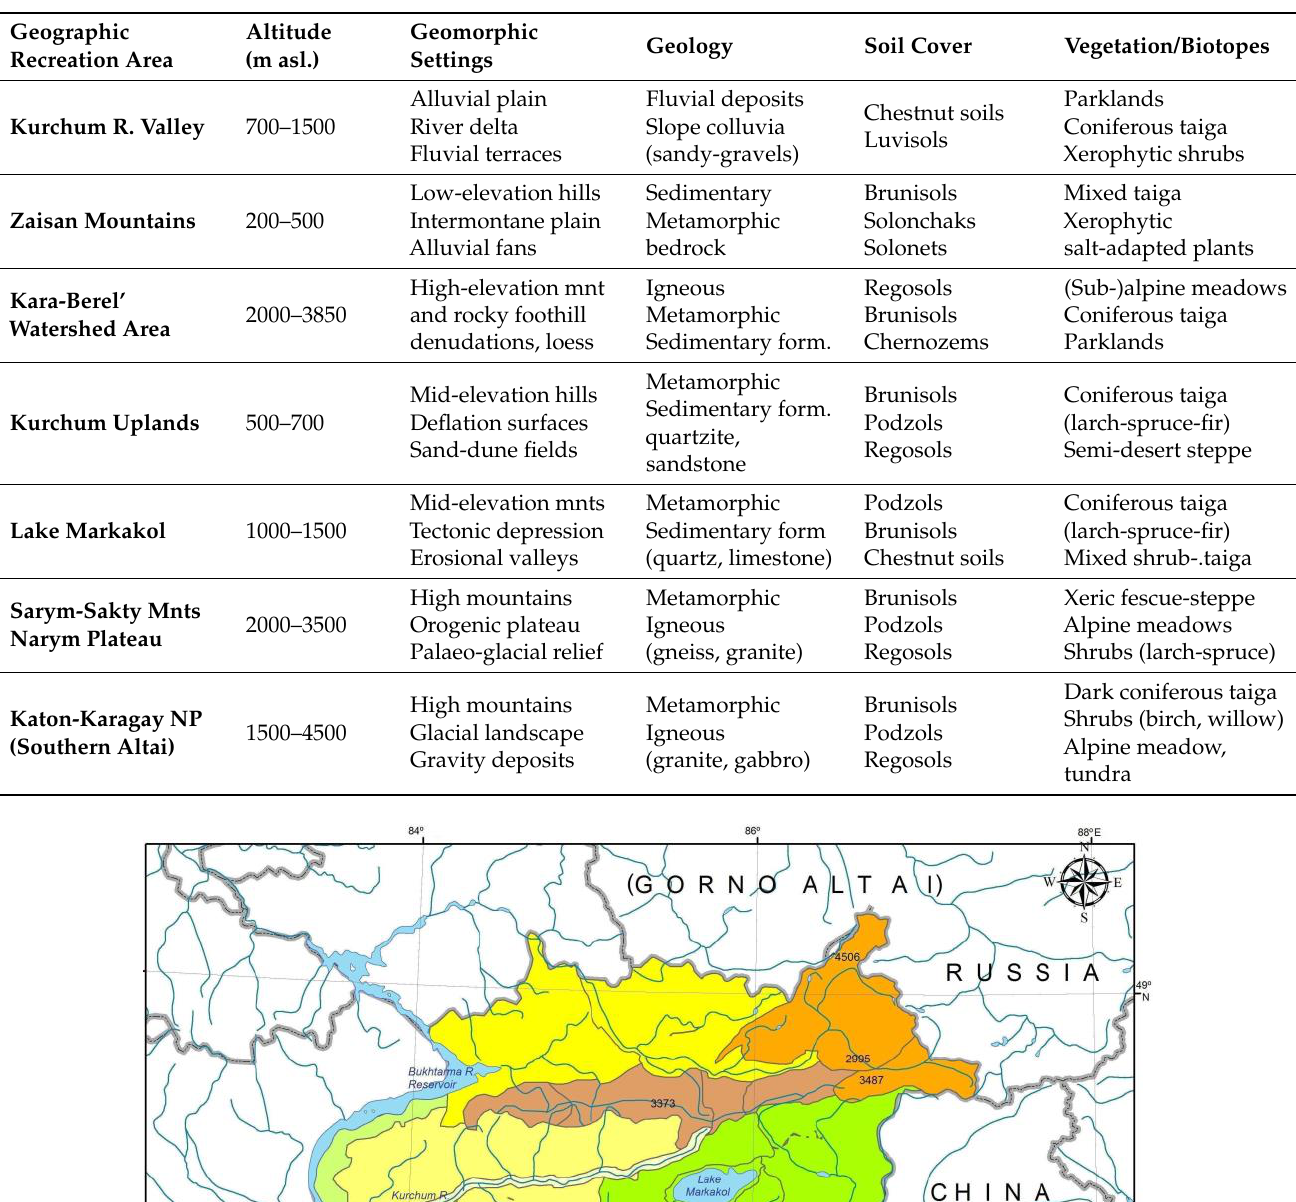
Table 3. Geographic recreation areas/sectors and the corresponding geo/ecosystems of the Southern Altai region.